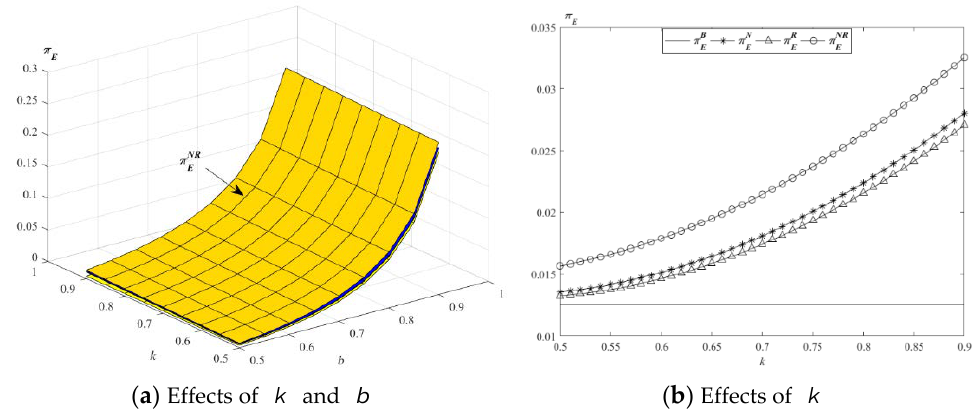
Figure 7. Impact of k and b on the optimal profit of E.